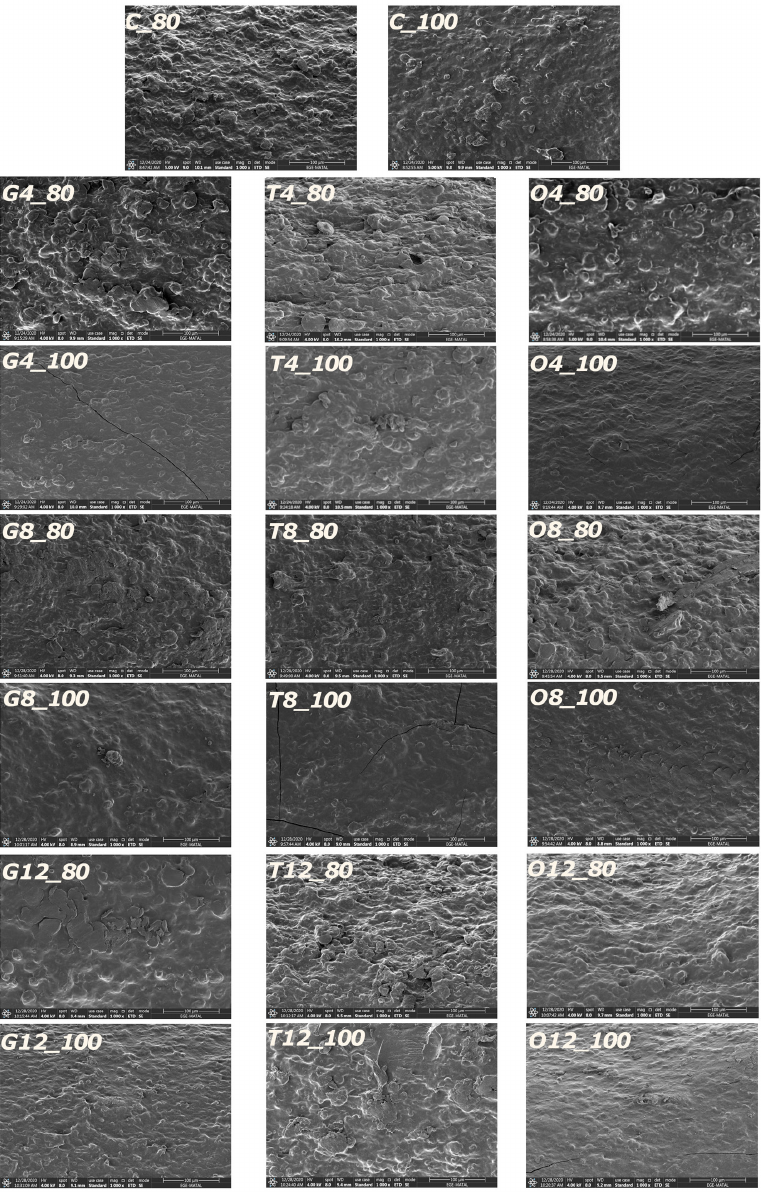
Figure 1. Surface microstructure of the uncooked noodle processed at 80 °C and 100 °C barrel temperatures in ×1000